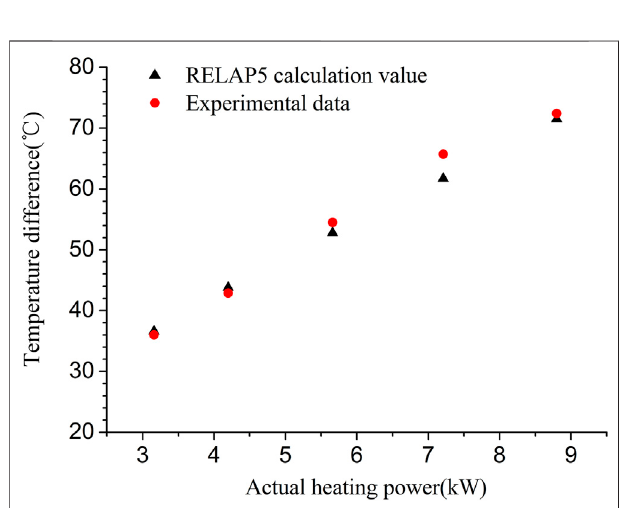
FIGURE 9 | Comparison of the LBE temperature difference under different heating power levels.